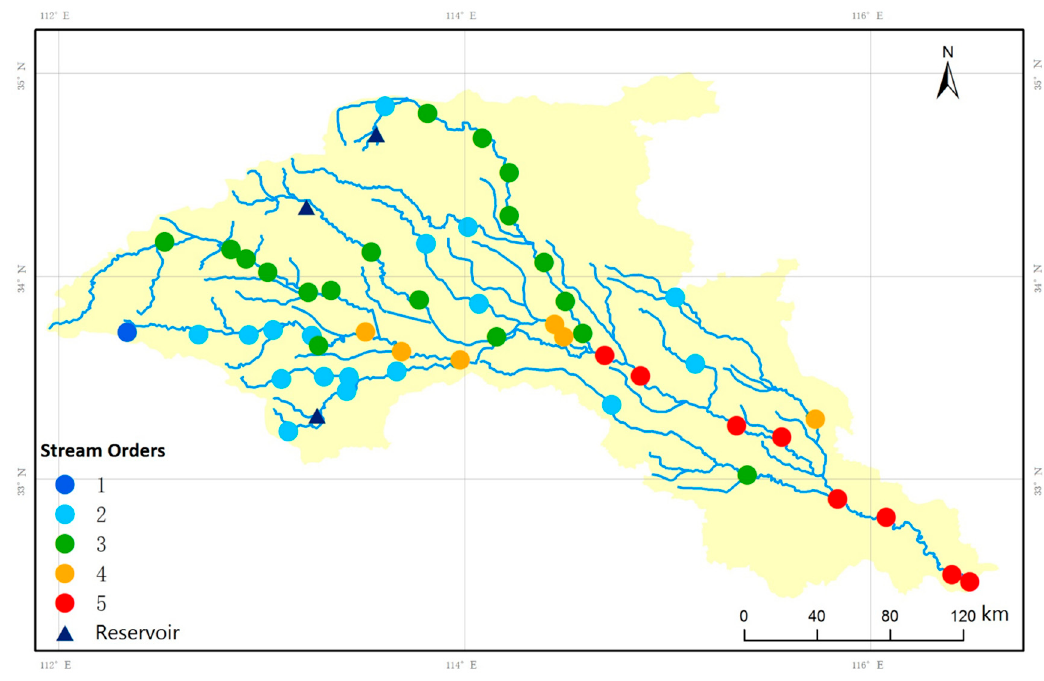
Figure 4. Classification of sampling sites in the Ying River with the Strahlar method.